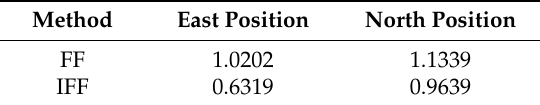
Table 8. RMSEs of the positions (m) for FF and IFF.